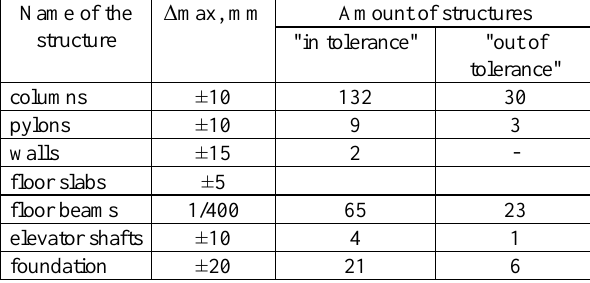
Table 1 . Summary table of identified deviations during the construction